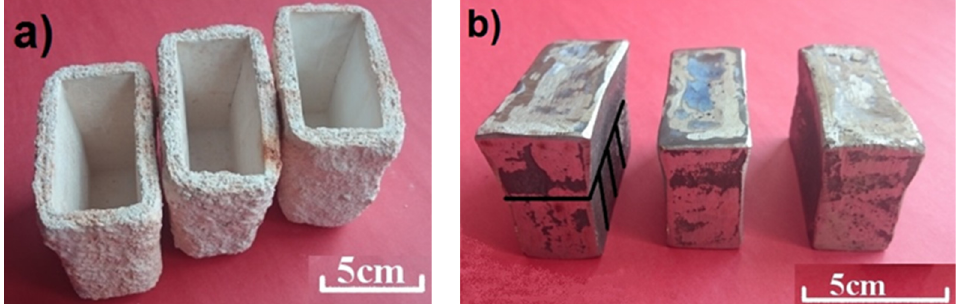
Figure 2. ( a ) molds used in tests. ( b ) examples of “Y” type test castings made from the examined steel and scheme of their cutting.